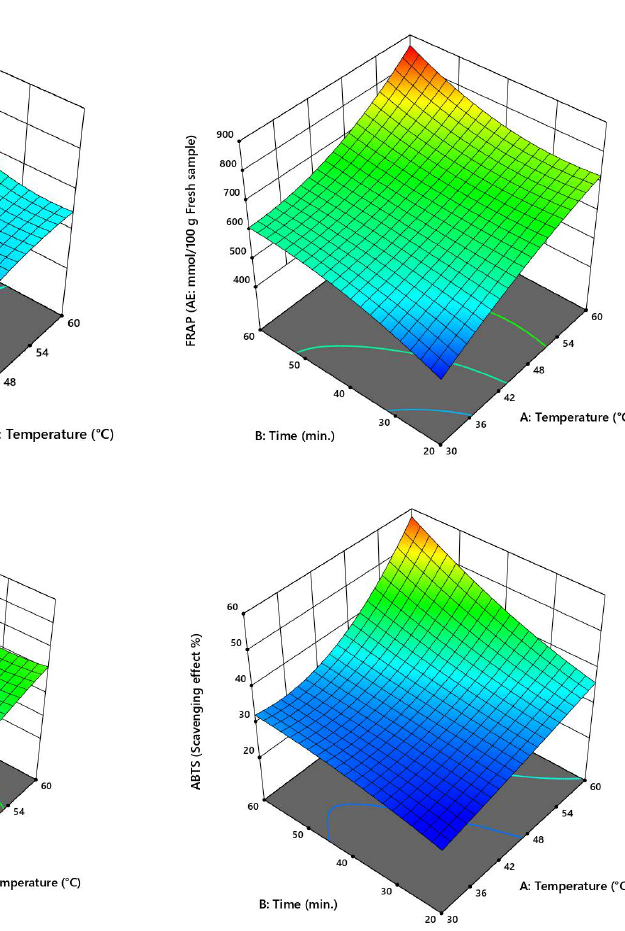
Figure 2. 3D response surface plot for response variables (TPC, TFC, FRAP, and ABTS) as a function of UAE with frequency 0, 28, and 40 kHz in Anbarah date palm fruit cultivar.